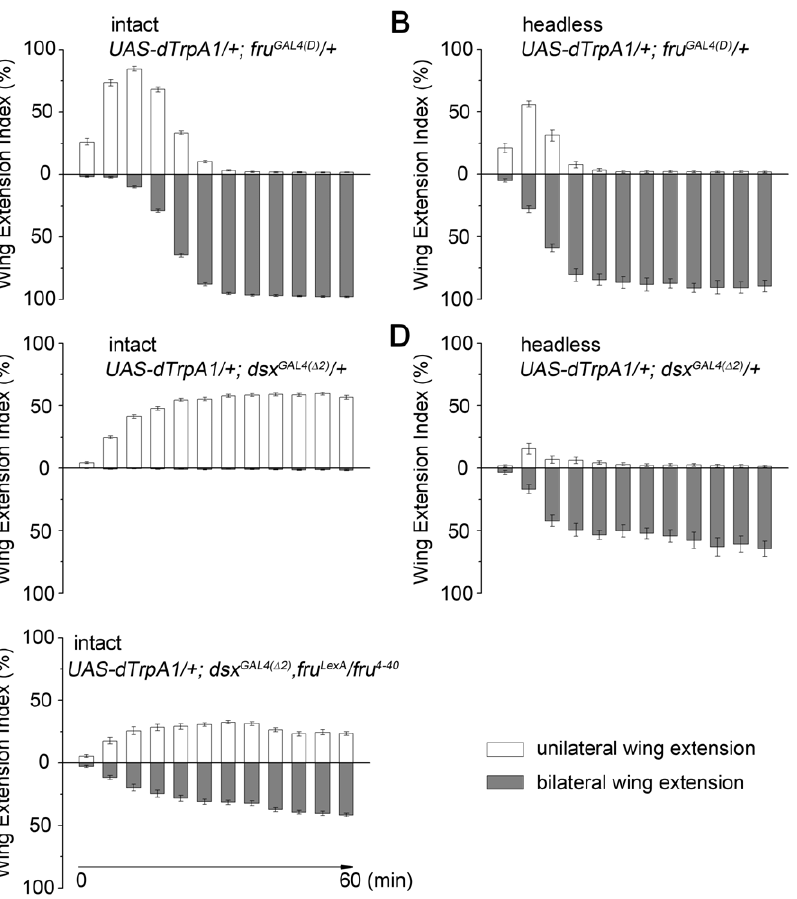
Figure 3. Wing extension patterns in intact and headless males. Individual males were transferred from 22 u C to 27 u C and recorded for 1 hour. For each male, indices of wing extension (for definition, see Materials and Methods), for either unilateral wing extension (white) or bilateral wing extension (gray), were analyzed for every 5-min period (i.e., 1–5 min, 6–10 min, and the last, 56–60 min; thus there are in total 12 indices for unilateral wing extension and another 12 indices for bilateral wing extension). Each bar represents a 5-min period. (A–B) Wing extension indices in intact (A) and headless (B) UAS-dTrpA1/ + ; fru GAL4(D) / + males at 27 u C. The transition from unilateral to bilateral wing extension occurs more quickly in headless males. (C–D) Wing extension indices in intact (C) and headless (D) UAS-dTrpA1/ + ; dsx GAL4( D 2) / + males at 27 u C. Activation of all dsx neurons produces consistent unilateral wing extension in intact males, but dominant bilateral wing extension in headless males. (E) Wing extension indices in intact UAS-dTrpA1/ + ; dsx GAL4( D 2) , fru LexA /fru 4–40 males at 27 u C. Loss of fru M function partially disrupts the wing extension pattern in intact males resulting in approximately equal unilateral and bilateral wing extensions. n =8 , 12 for each. Error bars indicate SEM. dTrpA1 / + ; fru GAL4(D) / + males with only one wing (either left or right), and were still able to detect simultaneous sine and pulse